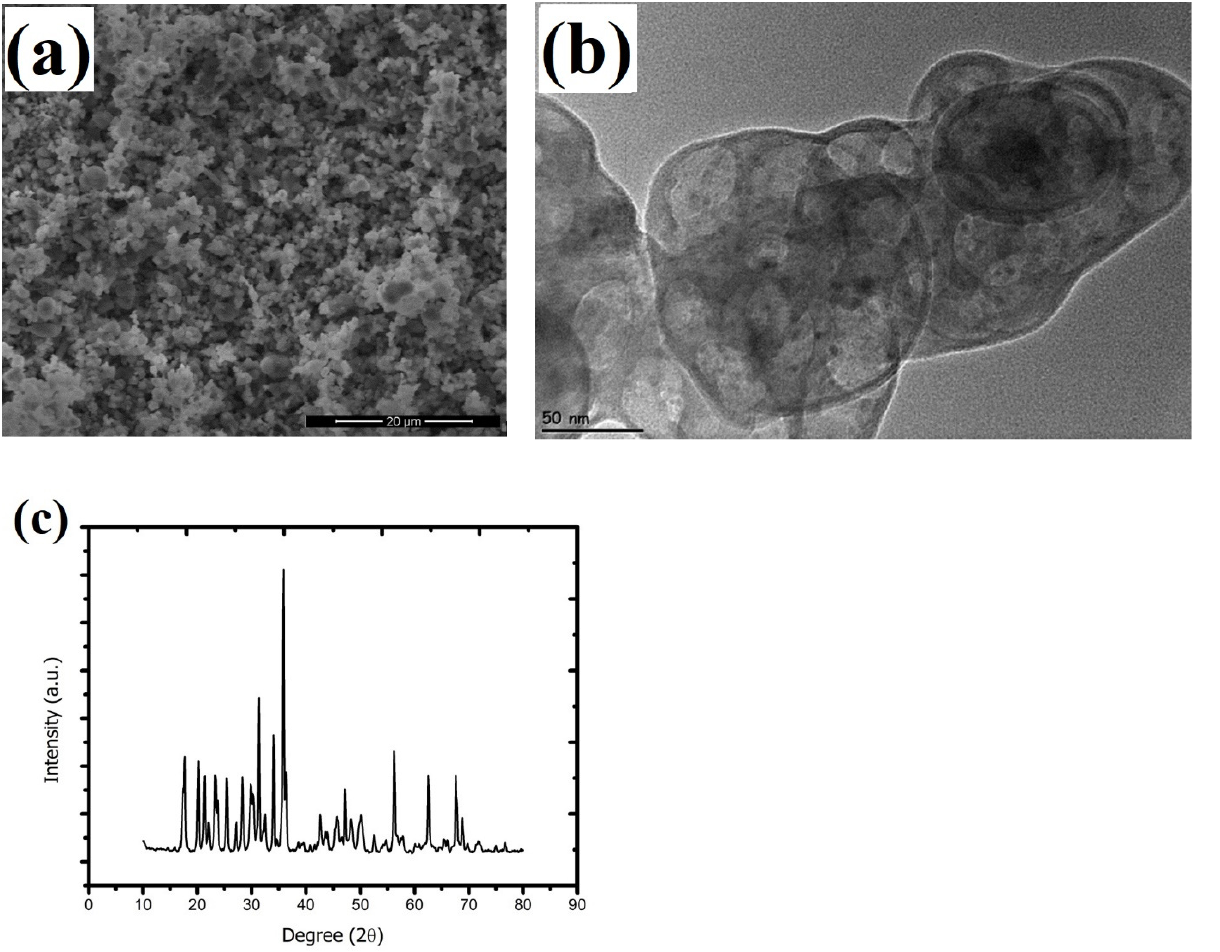
Figure 2. Characterization of zinc borate (Zn 3 BO 6 ) NPs. ( a )—scanning electron microscope (SEM) analysis of Zn 3 BO 6 NPs, ( b )—transmission electron microscope (TEM) analysis of Zn 3 BO 6 NPs and ( c )—X-ray crystallography (XRD) analysis of Zn 3 BO 6 NPs.